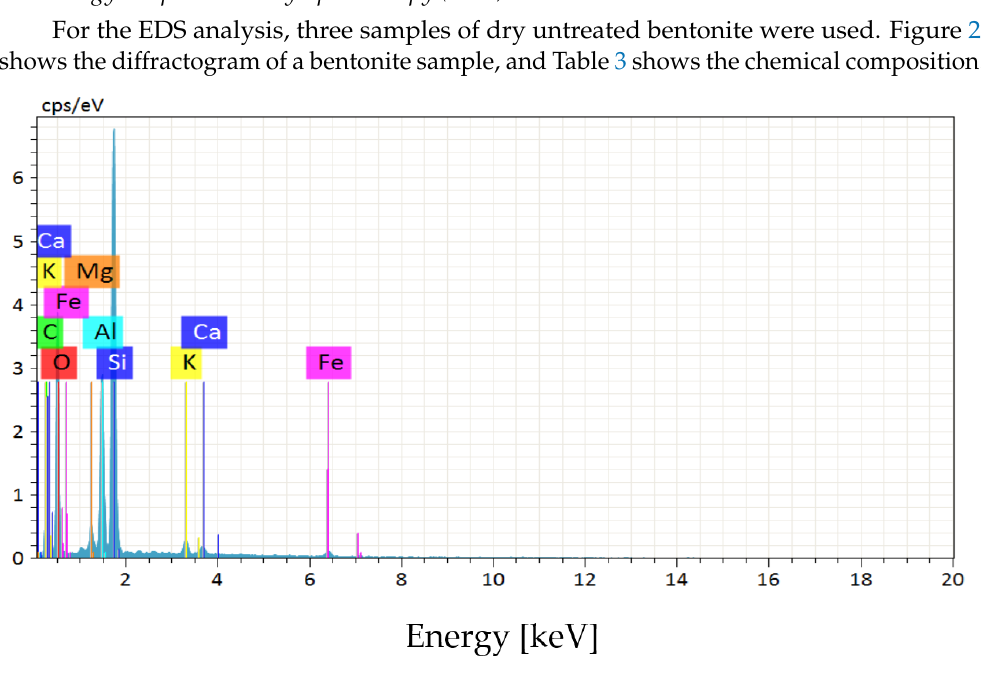
Figure 2. EDS analysis. Table 3. Bentonite chemical